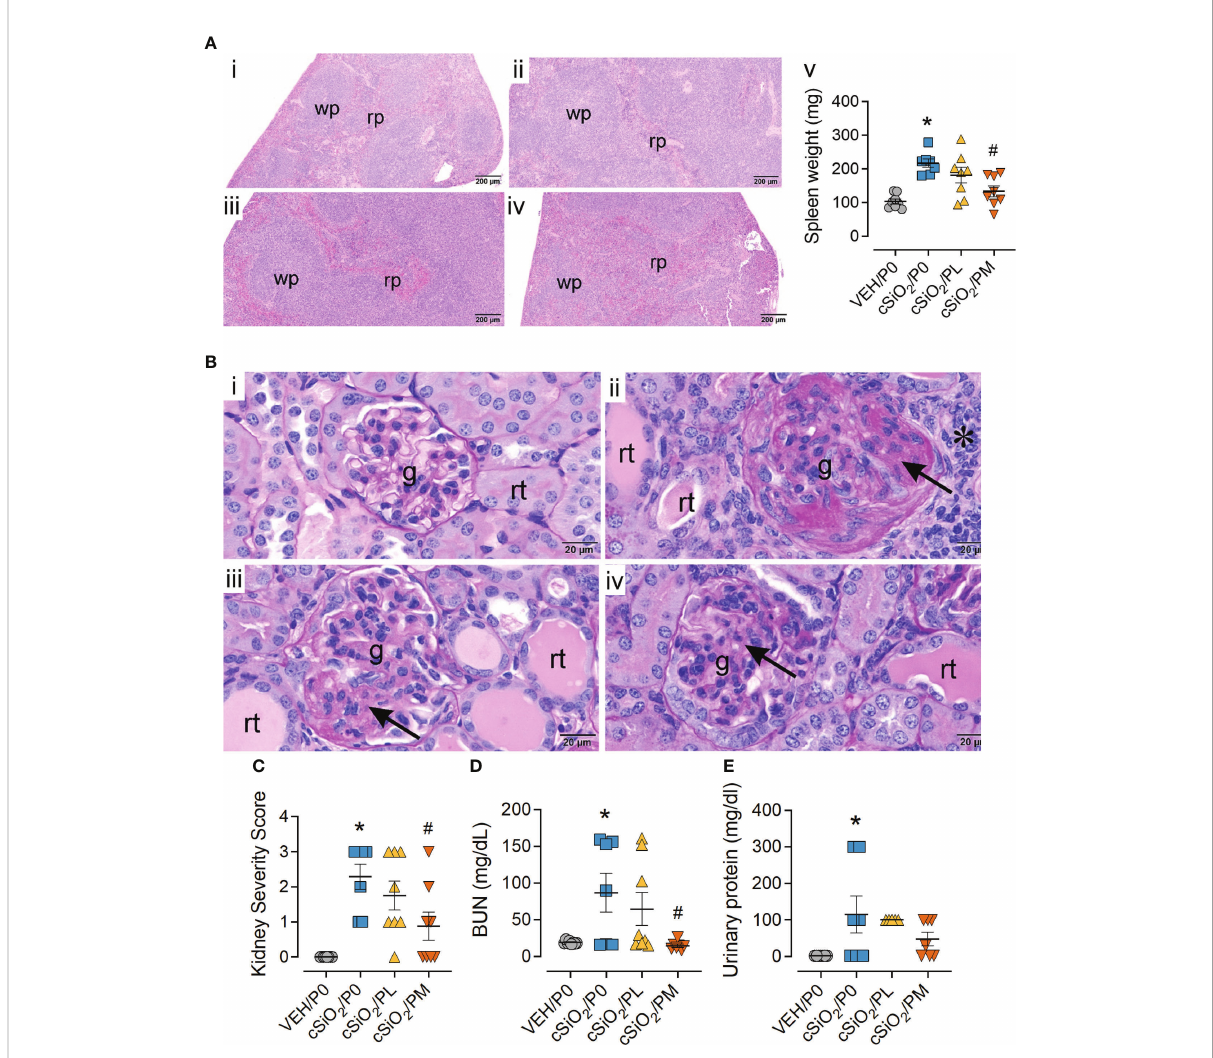
FIGURE 5 Moderate dose prednisone (PM) signi fi cantly reduced cSiO 2 -induced splenomegaly and glomerulonephritis. (A) Light photomicrographs of hematoxylin and eosin-stained splenic tissue and (B) periodic acid Schiff (PAS) and hematoxylin-stained renal tissue from (i) VEH/P0, (ii) cSiO 2 / P0, (iii) cSiO 2 /PL, and (iv) cSiO 2 /PM mice. Splenic white pulp (wp) is increased (lymphoid cell hyperplasia) in A.ii and A.iii compared to A.i. WP is similar in VEH/P0 (A.i) and cSiO 2 /PM (A.iv) mice. Prednisone inhibited cSiO 2 -induced increases in spleen weight (A.v) Glomeruli (g) in B.ii and B.iii are enlarged and hypercellular with PAS-stained membranous tissue (arrows). Dilated renal tubules (rt) with luminal proteinaceous material are present in B.ii and B.iii, but not in B.i. PM treatment results in modest glomerular and renal tubular histopathology in B.iv. (C) Individual kidney sections were semi-quantitatively scored based on the modi fi ed International Society of Nephrology/Renal Pathology Lupus Nephritis Classi fi cation system described methods for lupus nephritis score. (D) PM treatment signi fi cantly reduced cSiO 2 -induced plasma BUN at time of necropsy (E) but was ineffective in signi fi cantly reducing urinary protein assessed at 12 wks PI. Statistical analyses were performed as described in Methods. *Indicates p<0.05 for VEH/P0 vs cSiO 2 /P0; # indicates p<0.05 for cSiO 2 /P0 vs cSiO 2 /PL or cSiO 2 /PM